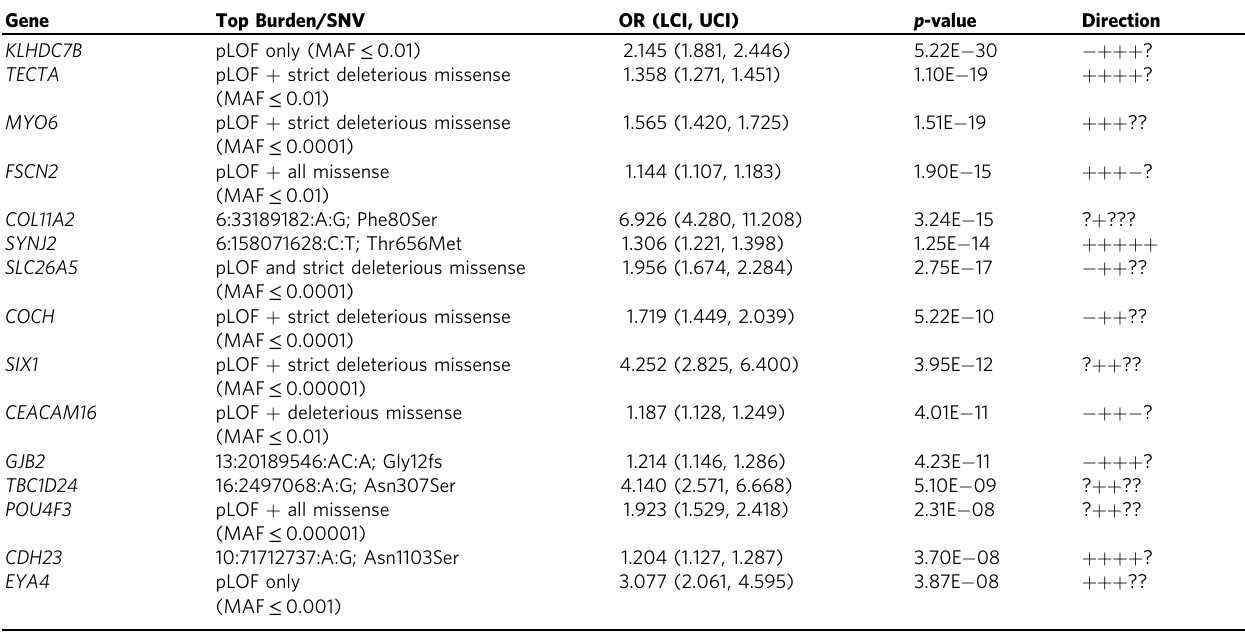
Table 2 Nonsynonymous rare (minor allele frequency, MAF < 0.01) variants and gene burdens associated ( P < 5 × 10 − 8 ) with hearing loss in